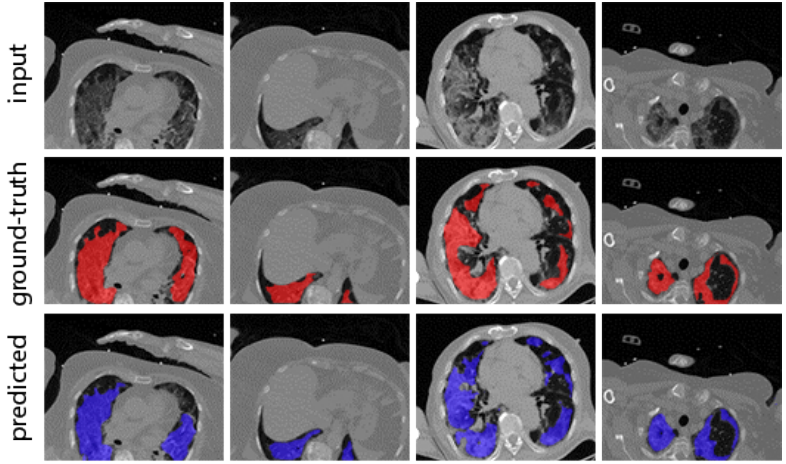
Figure 4. Qualitative and quantitative results of the proposed segmentation model. Input CT slices, ground truth ( red ) and predicted ( blue ) infected segments are shown in the first, second and third column, respectively.